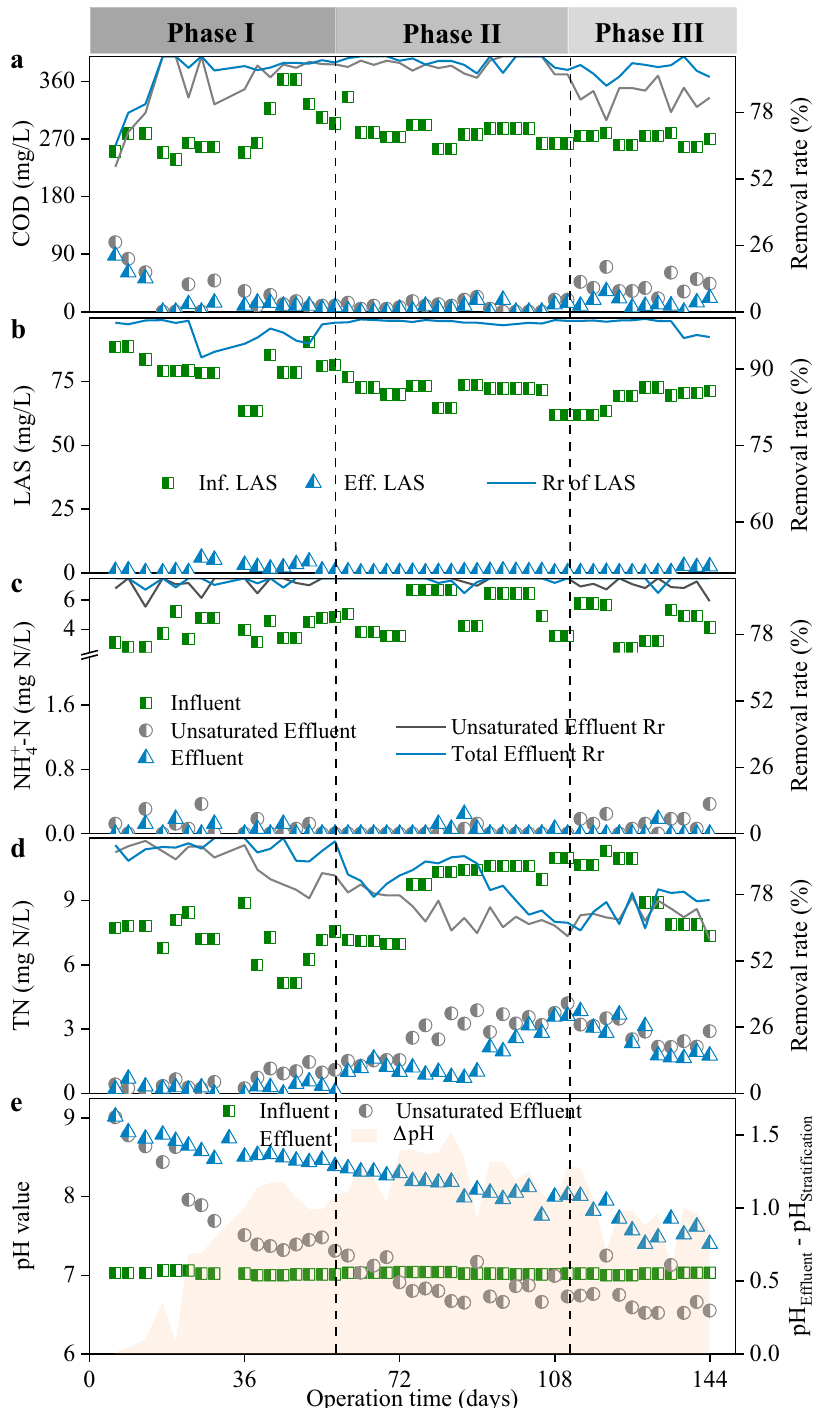
(cid:2) N , d TN, and e pH at different Phases in the bio-enhanced 4